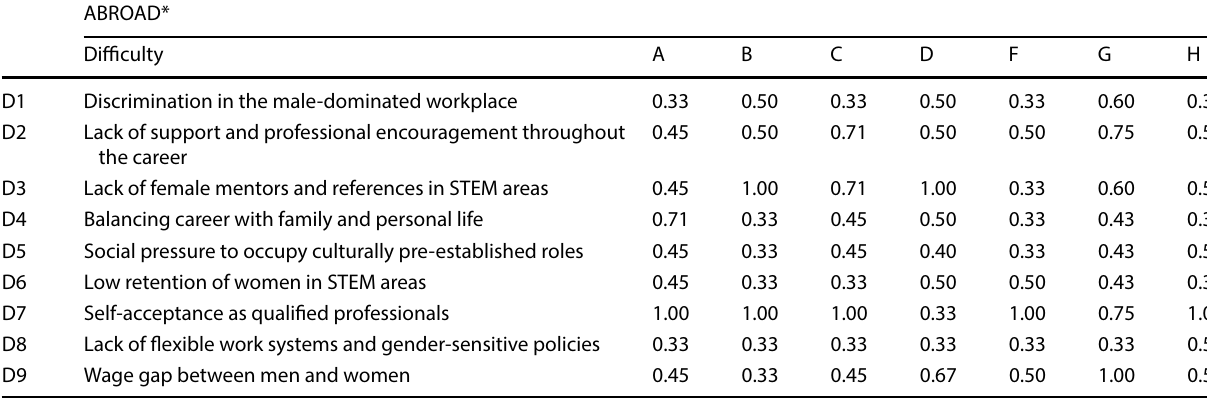
Table 6 Grey relational coefficients of the analysis of scores assigned for abroad